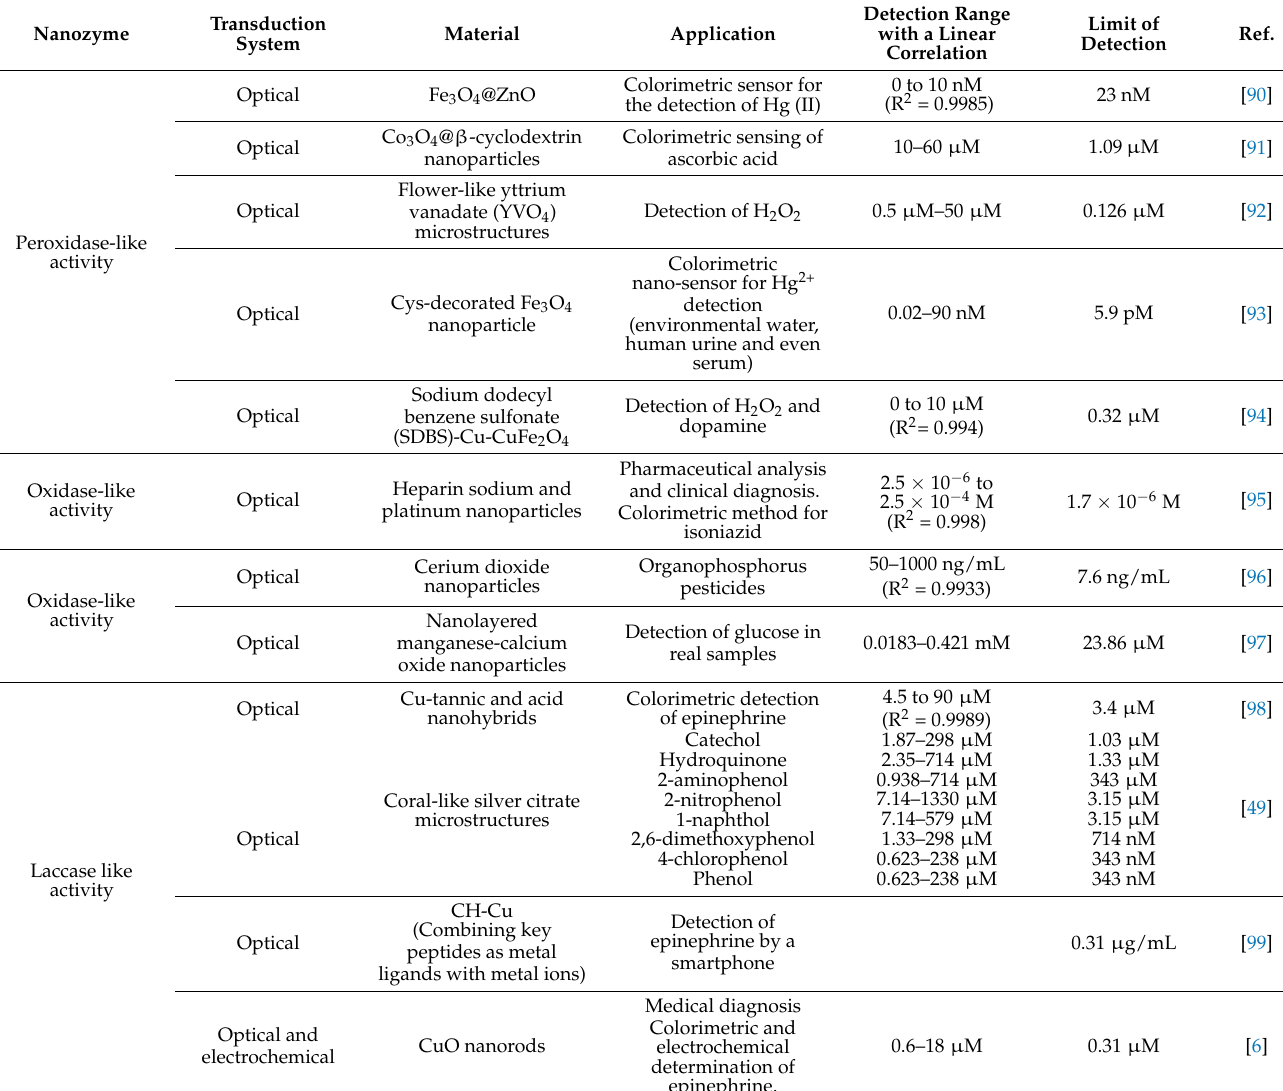
Figure 5. Catalytic action of an enzyme and nanozyme. Table 6. Nanozymes (enzyme-like activity) specifications and